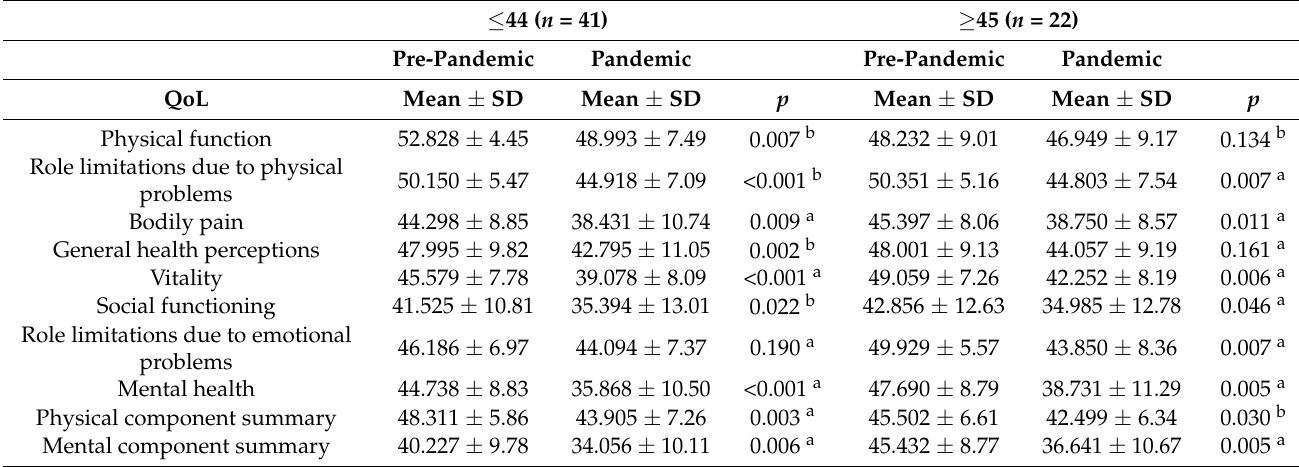
Table 3. Comparison of 8 SF-36 QoL scales and two summary measurements between pre-pandemic and pandemic timeframes for each age group ≤ 44 and ≥ 45 years ( n =